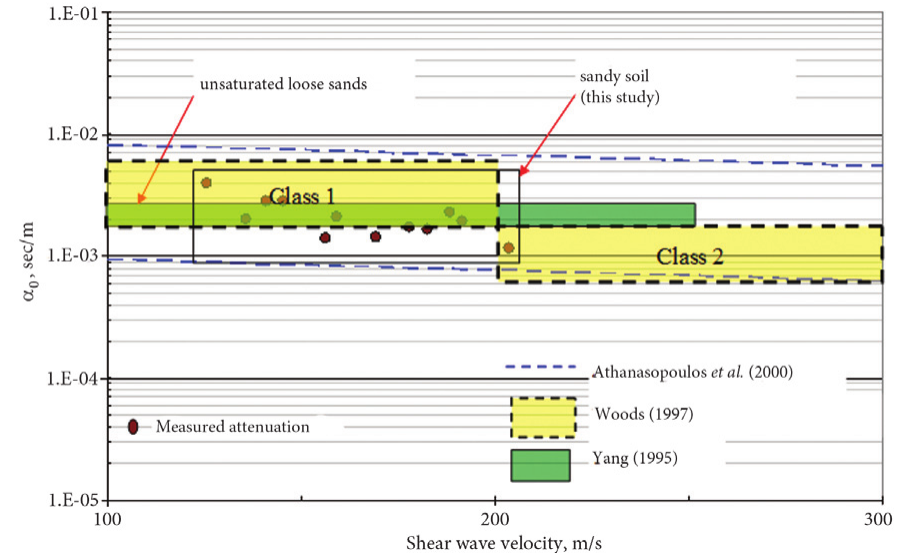
fig. 11. A comparison of the frequency-independent attenuation factor versus shear wave velocity from this study and previous